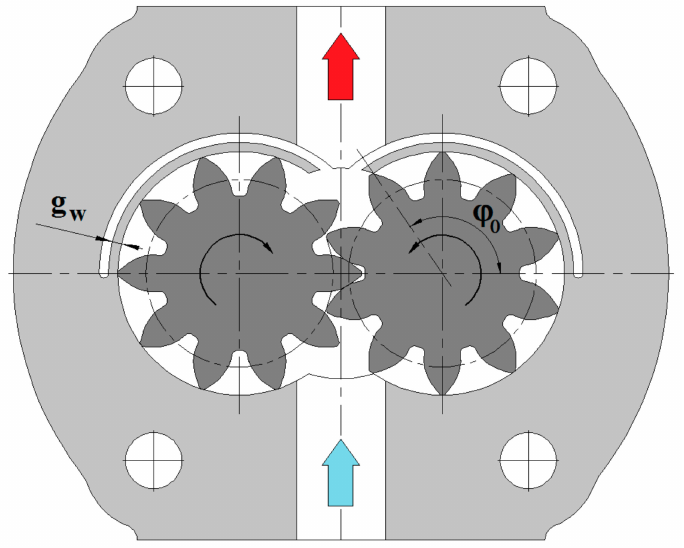
Figure 4. The first version of circumferential compensation with a lip of a constant thickness, according to Patent No. PL221099 (Patent Application No. P.397539 [16]).